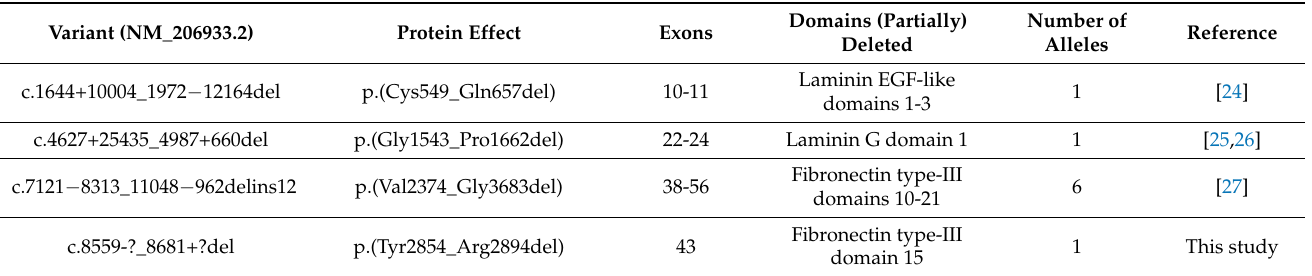
Table 2. Overview of CNVs identified in this